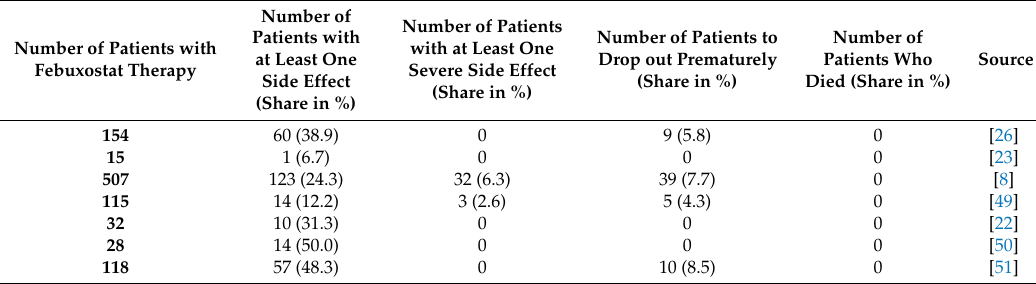
Table A1. Adverse events in the original works (number of patients examined per study (column 1); patients with at least one side effect (column 2); patients with at least one severe side effect (column 3); patients who dropped out of the study prematurely (column 4); patients who died (column